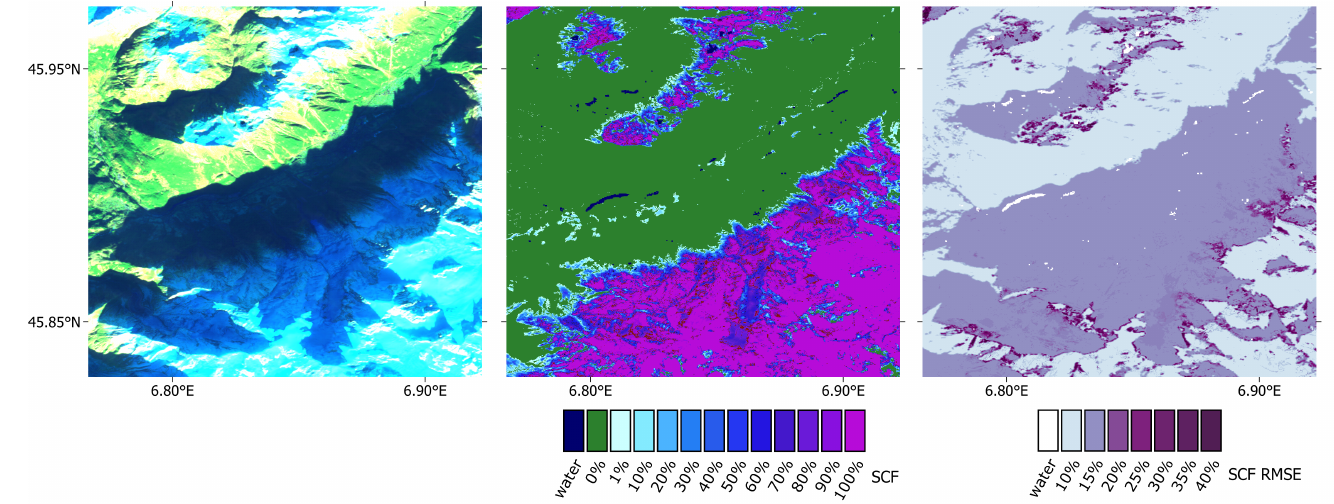
Figure 6. ( Left ): Sentinel-2B MSI false colour composite (bands 11, 8A and 3) taken on 25 November 2020 in the European Alps near Chamonix (32TLR) with the RGB colours scaled from 0 to 0.25, 0 to 0.15 and 0 to 0.15, respectively. ( Center ): LAMSU SCF derived from Sentinel-2B MSI data at 20 m resolution. Right : LAMSU SCF RMSE at 20 m resolution. Water mask source: EC